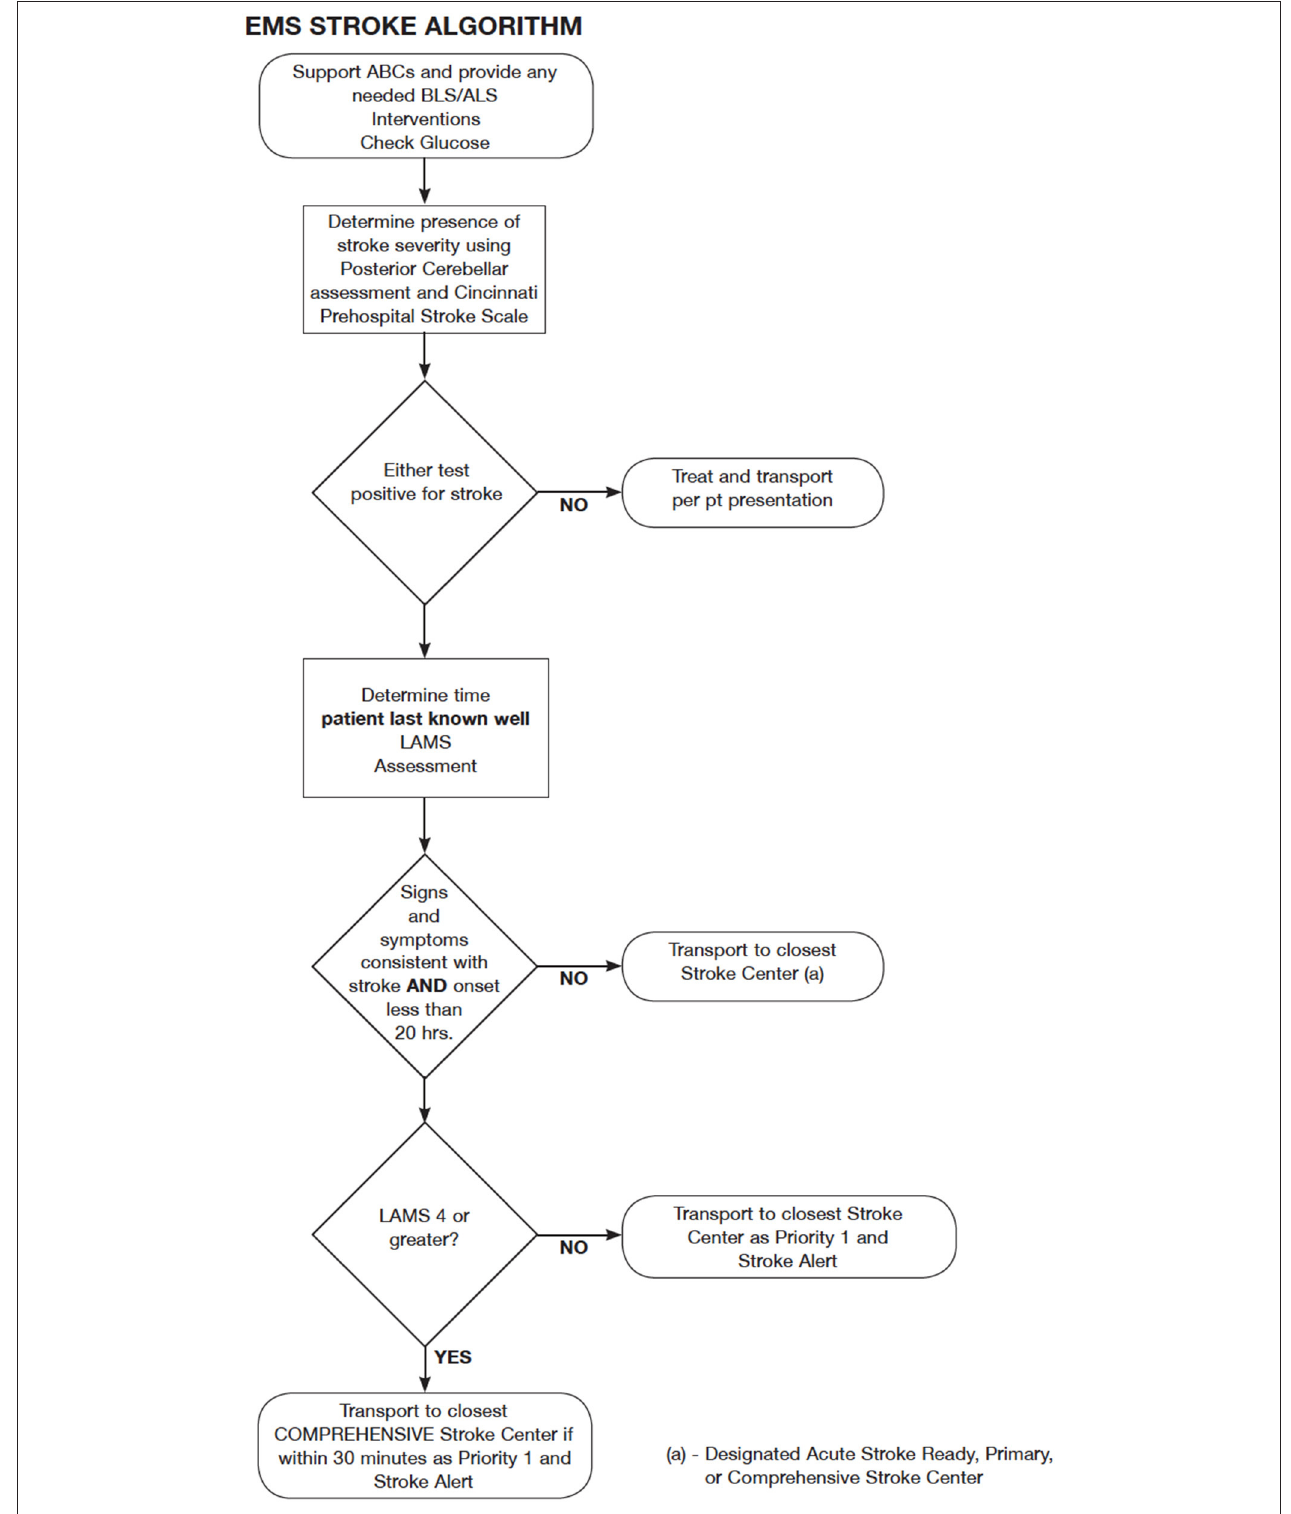
FIGURE 2 | MIEMSS 2019 Acute Stroke EMS Routing Pilot algorithm (with permission from MIEMSS).